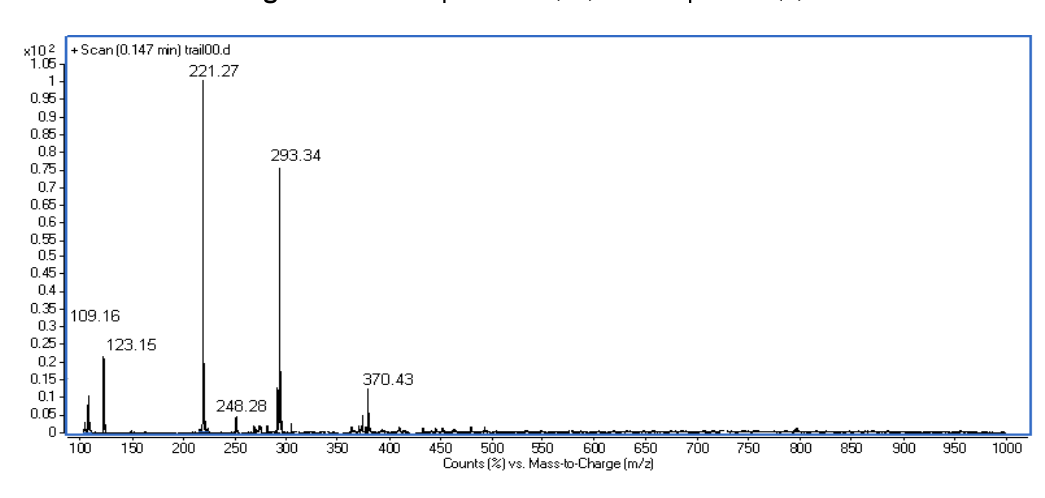
Figure 5. Mass spectrum (EI) of compound ( 3